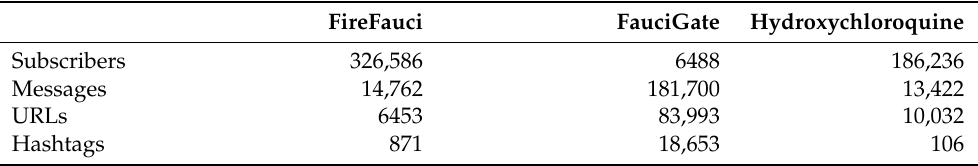
Table 7. Statistics for the collected COVID-19-related Telegram disinformation